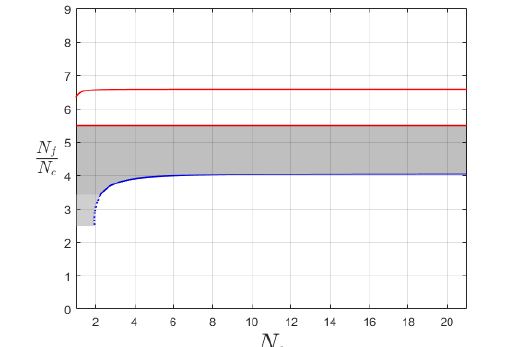
(b) An alternative scenario for the conformal window. The Banks-Zaks (cid:12)xed point in this case is destabilized by the g V and g V interac- 1 2 tions.